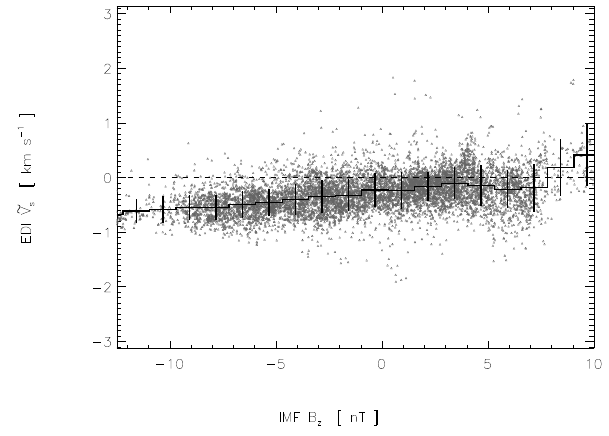
Fig. 7. Scaled 10-min averaged convection velocities ˜ V s vs. IMF B z for the 20 cases listed in Table 1. Overplotted in black are the average and standard deviations of the velocities.